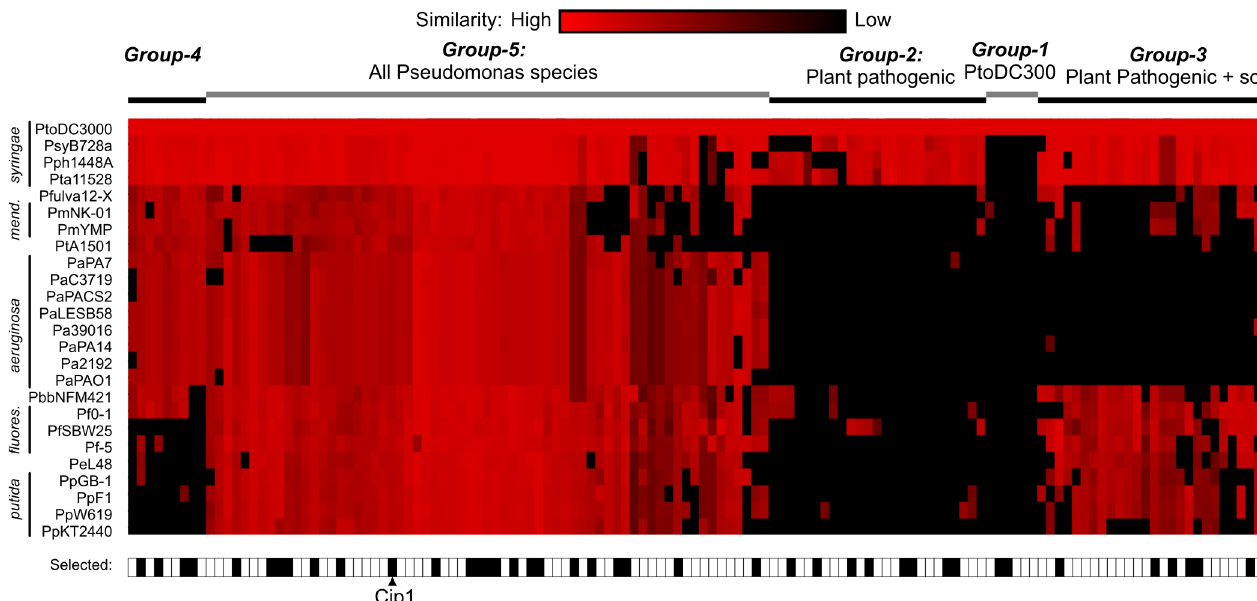
Fig 2. Occurence of small, secreted non-annotated proteins of PtoDC3000 in other Pseudomonas species. BLAST scores were generated for each of the 131 small secreted, non-annotated proteins against each of the protein databases of 24 sequenced Pseudomonas species. BLAST scores were presented in shades of red, and black boxes represent no significant BLAST score. Blast scores are clustered over both the species and proteins. Conservation of the proteins occurs in five groups (1 – 5). Representative putative proteins having the highest SP scores were picked from each of these classes and produced and purified (black boxes on the bottom). See S1 Fig for more